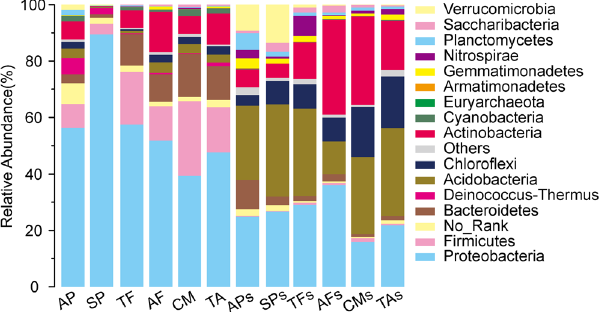
Figure 5. The comparison of bacterial composition based on the top 15 phyla of bacteria on all samples. Others, the remained phyla with lower relative abundance; No_Rank, no annotation